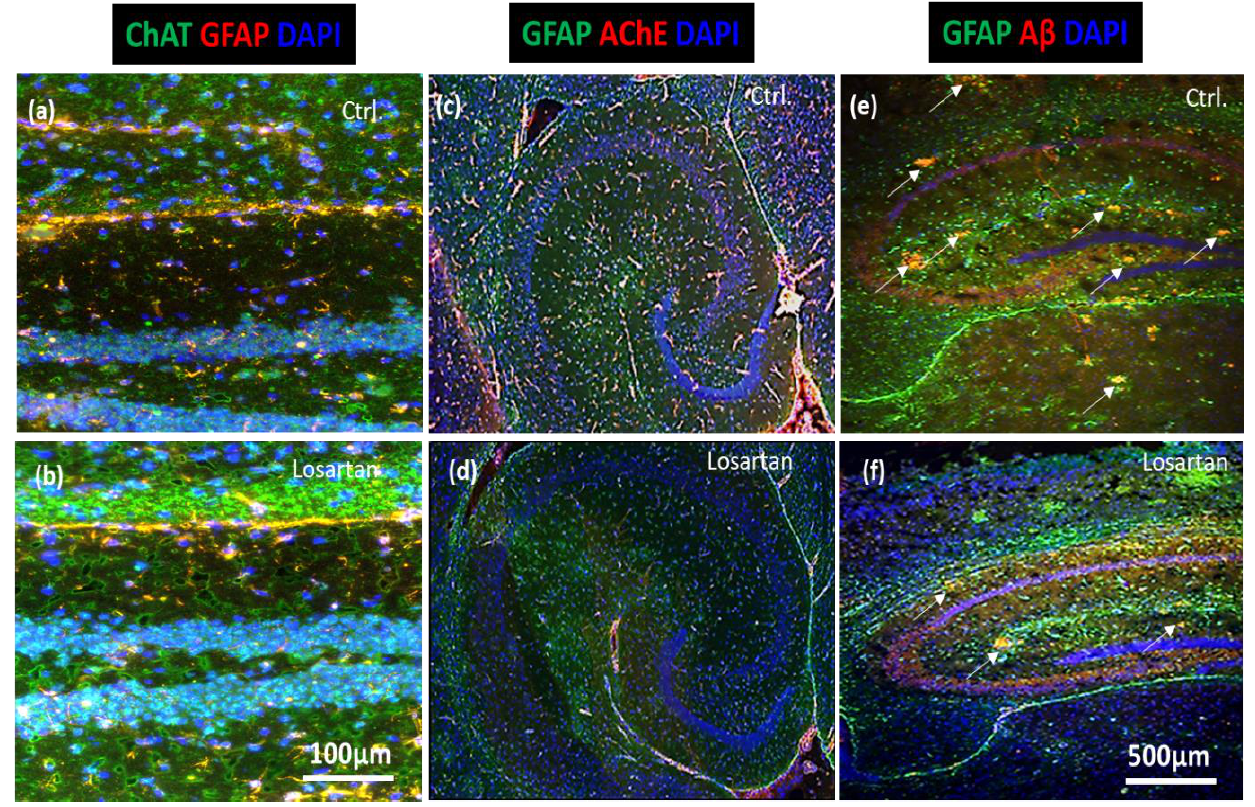
Figure 5. Losartan-mediated changes in neurogenesis and neuroprotection markers in the hippocampus of APP/PS1 mice. ( a – b ) Immunofluorescent analysis of ChAT (green) and glial fibrillary acidic protein (GFAP) (red) in losartan vs. vehicle (Ctrl.) treated APP/PS1 mice. ( c – d ) Expression of AChE (red) and GFAP (green) in losartan/vehicle treated APP/PS1 mice. ( e – f ) Aβ plaques (red) and GFAP staining of losartan and vehicle (Ctrl.) treated APP/PS1 mouse brain sections. Cell nuclei are stained with DAPI (blue), scale bar in ( b ) corresponds to the images shown in ( a ) and ( b ), scale bar in ( f ) corresponds to ( c – f ). ( a – f ) Representative images out of 10 sections per brain taken from n = 3 mice analyzed per treatment group.